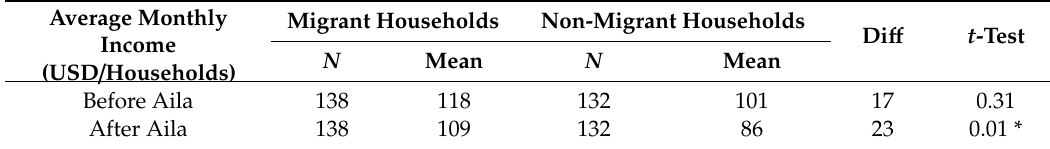
Table 8. Average monthly income of migrant and non-migrant households (before and after